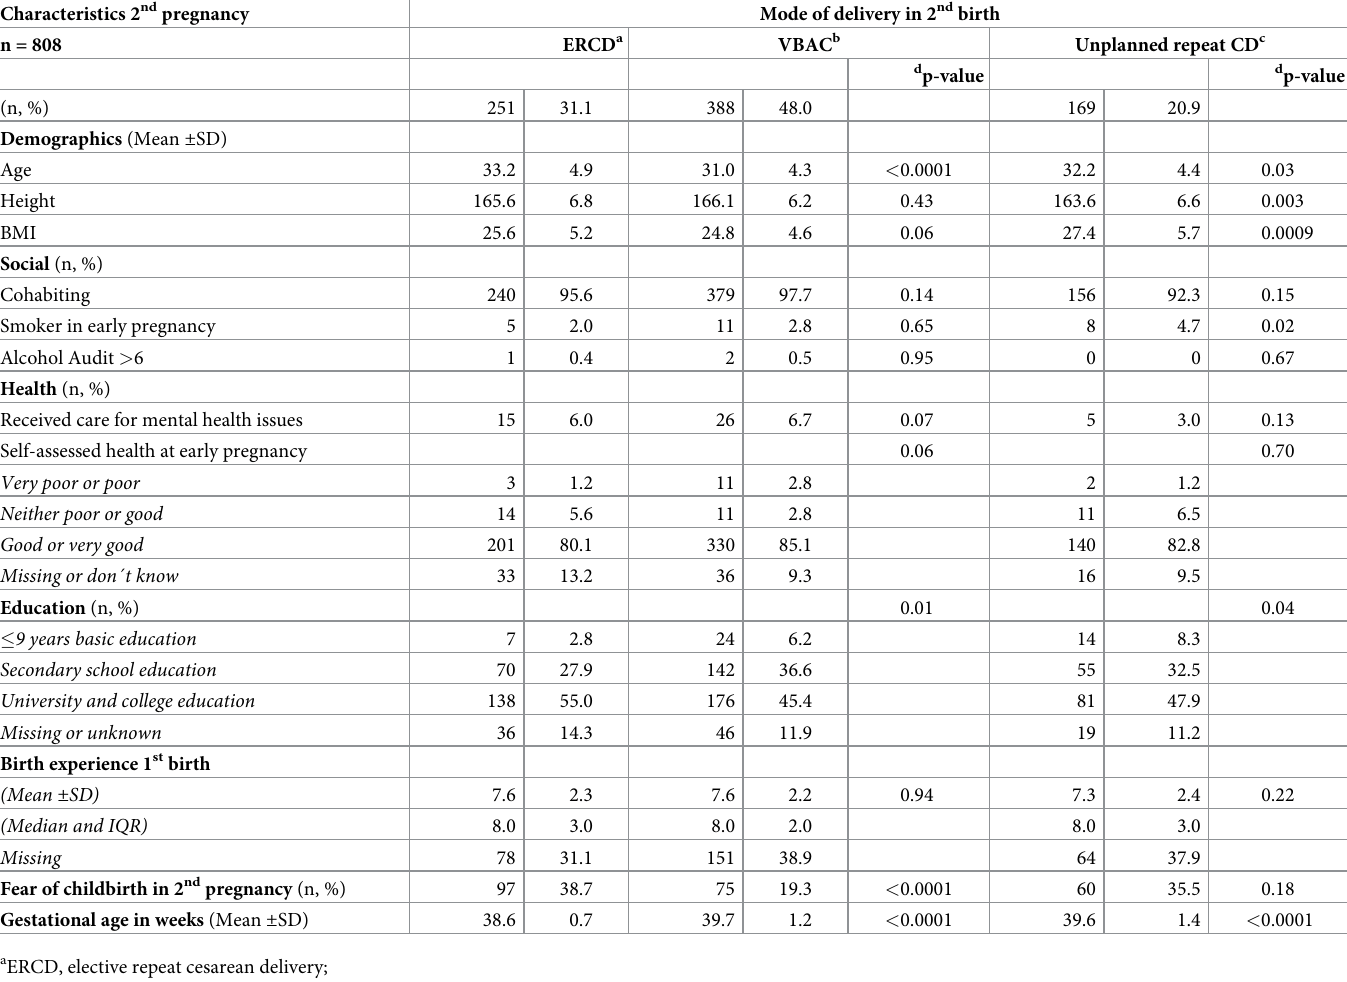
Table 1. Maternal characteristics by mode of delivery in 2 nd